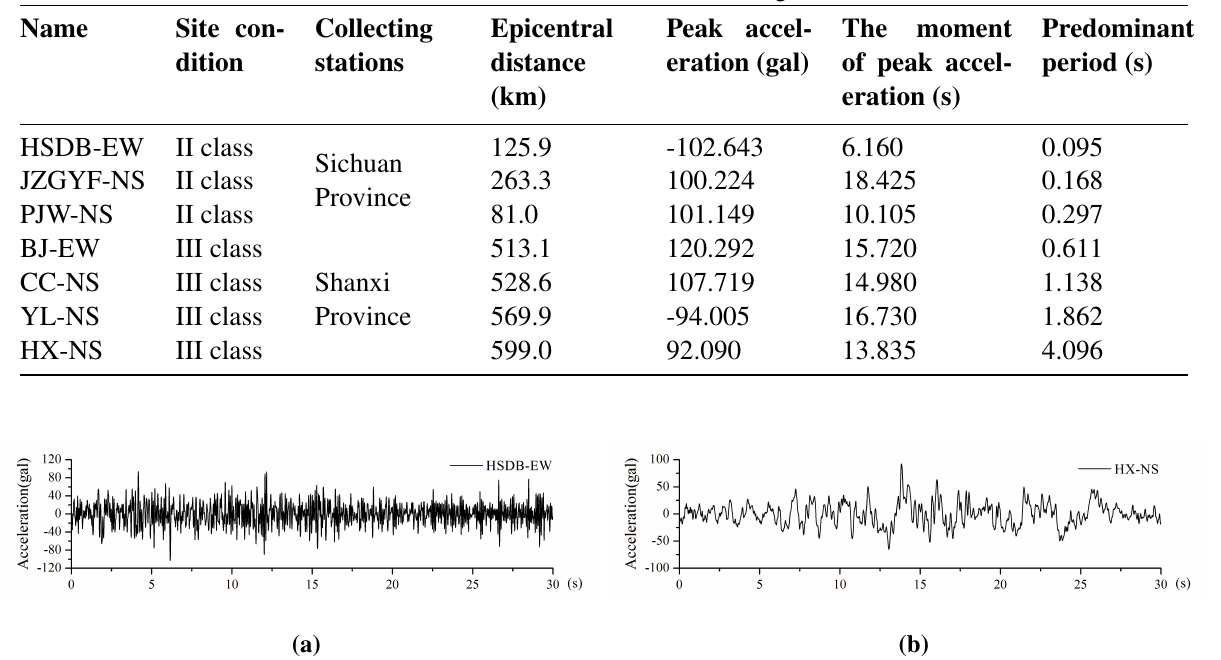
Table 2 Basic information of the selected seismic ground motions.